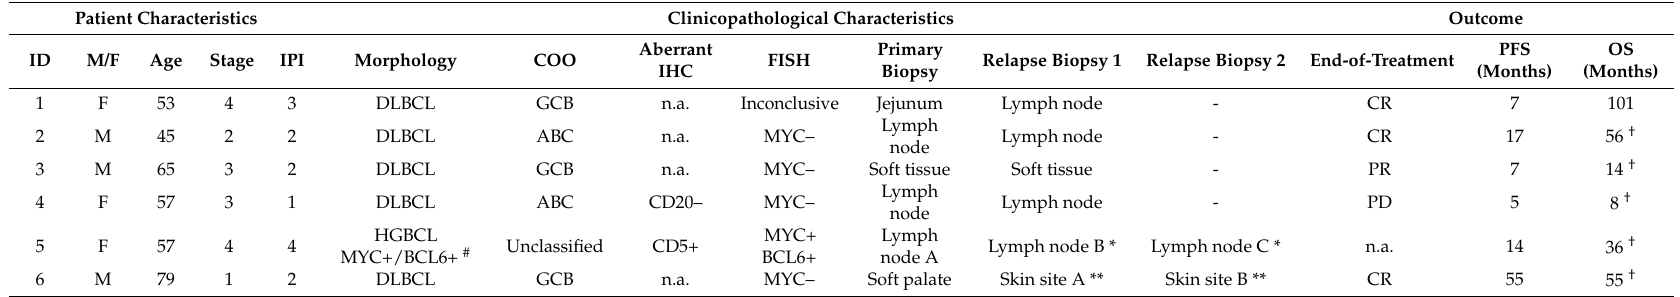
Table 1. Patient and clinicopathological characteristics of the six patients evaluable for mutational